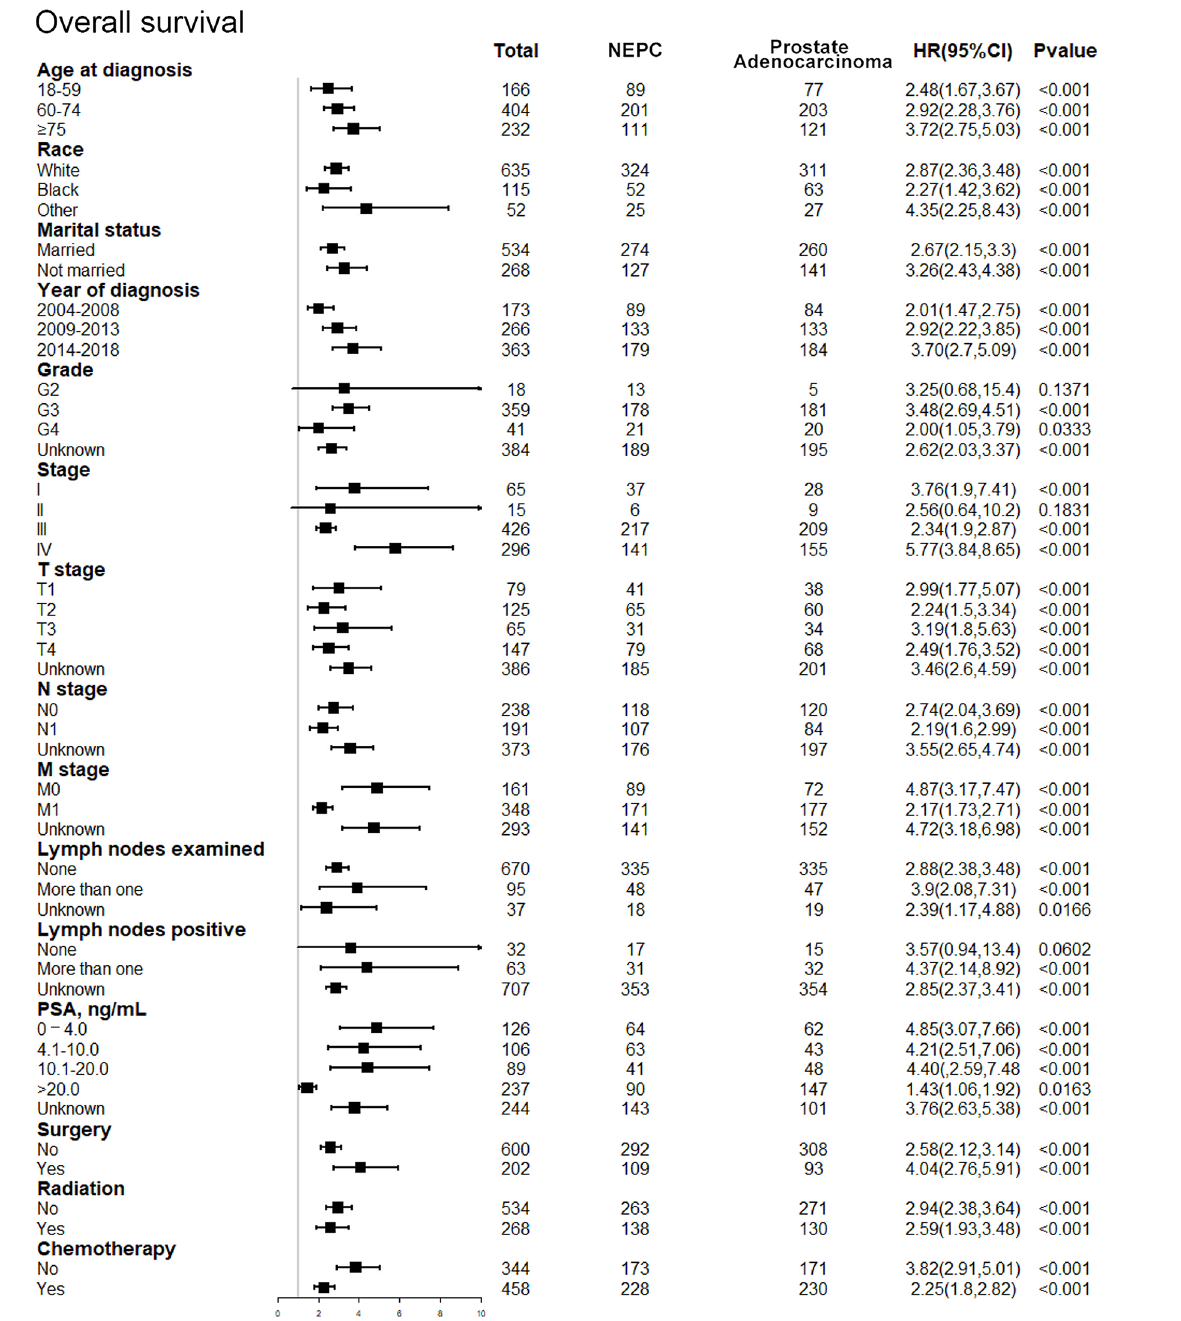
FIGURE 3 | Forest plot of the subgroup analysis for NEPC and prostate adenocarcinoma in OS. NEPC, neuroendocrine prostate cancer; OS, overall